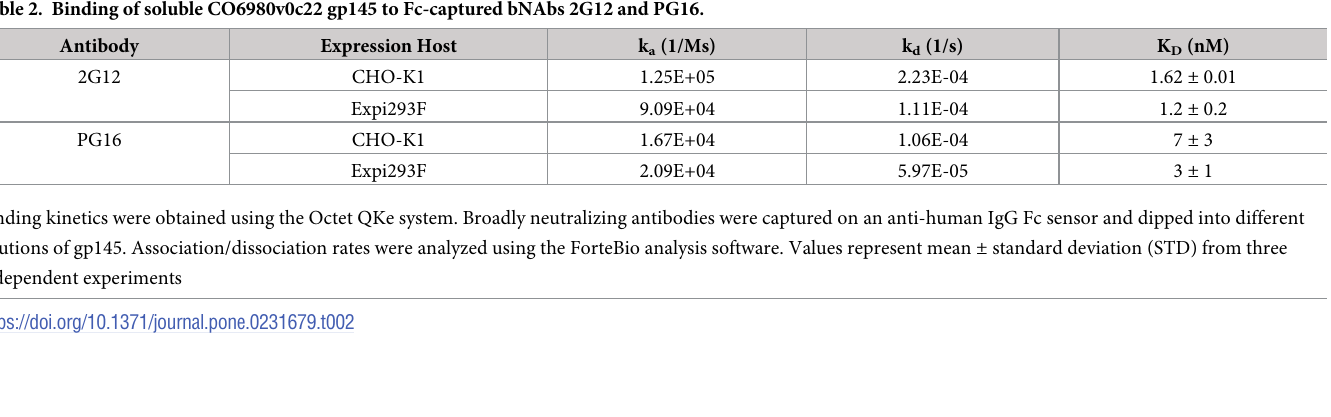
Table 2. Binding of soluble CO6980v0c22 gp145 to Fc-captured bNAbs 2G12 and PG16. Antibody